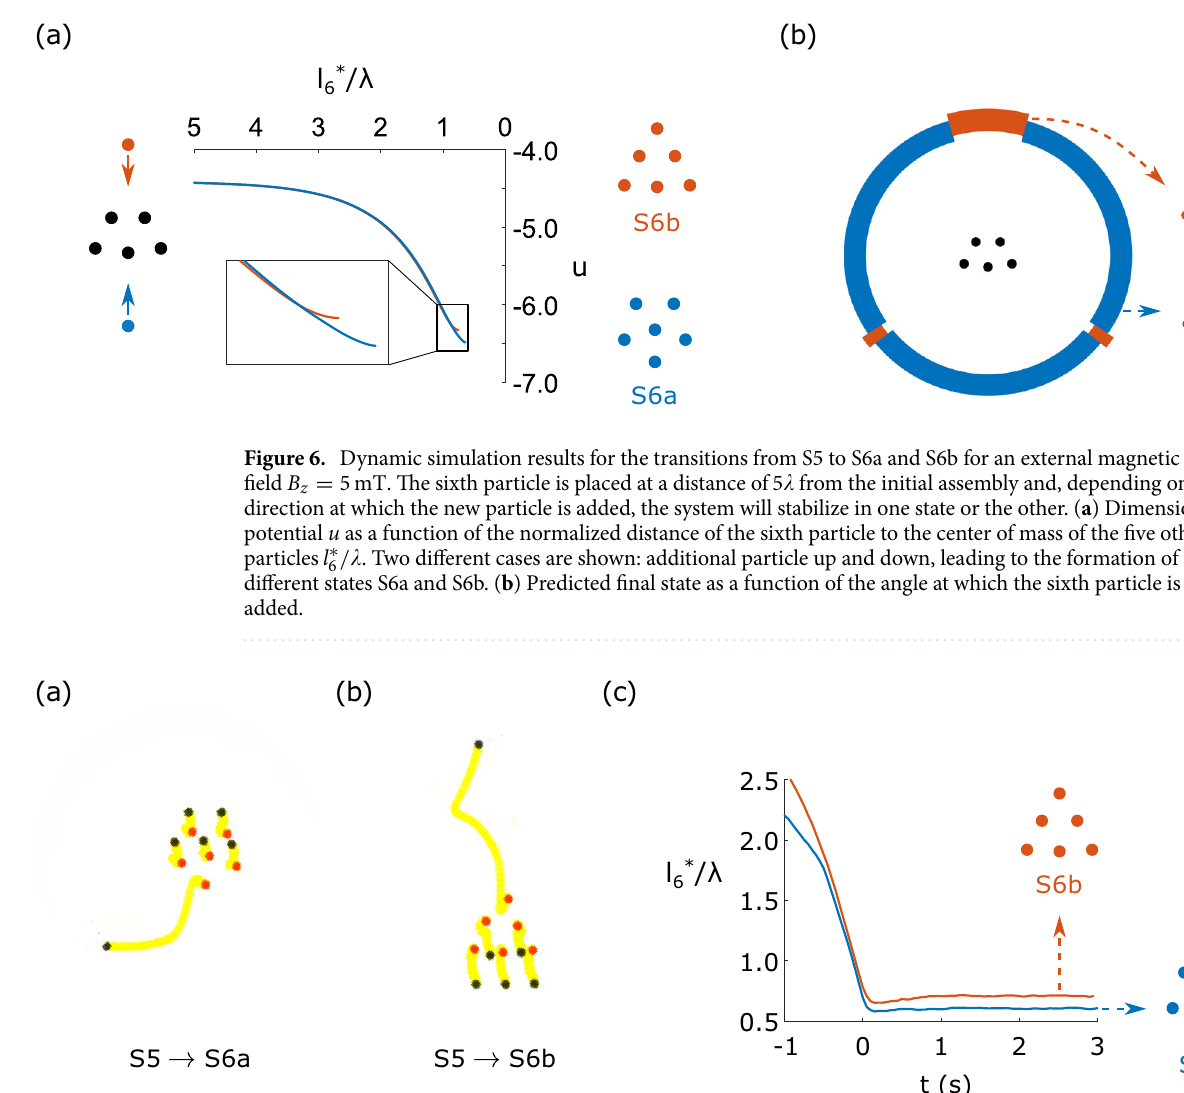
4.8mT . In black, the =